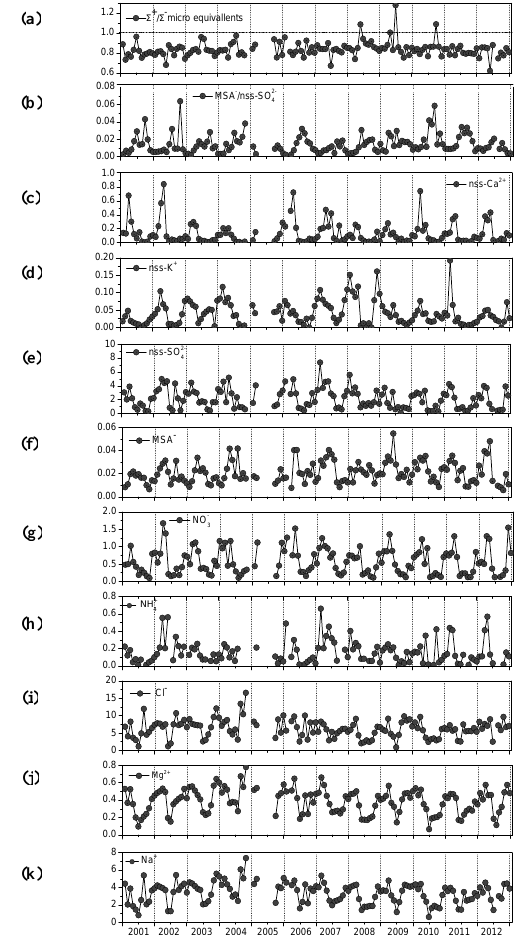
Figure 5. Temporal variations of different measured/derived inor- ganic ions (µgm − 3 ) and mass ratios over the western North Pacific during 2001–2012. Each data point represents 1 month in each year.